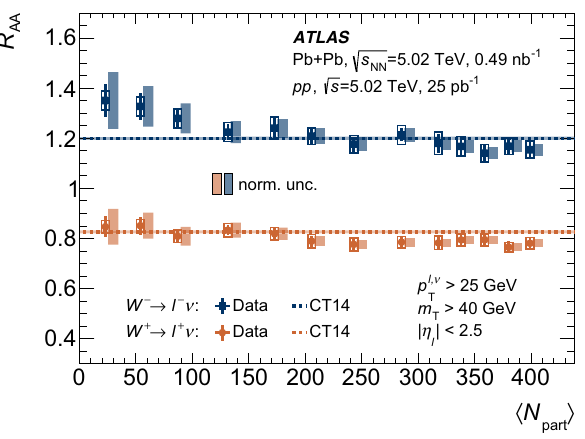
Fig. 14 Nuclear modification factor R AA obtained from the fiducial W + and W − boson production yields as a function of (cid:4) N part (cid:5) . Error bars show statistical uncertainties, whereas systematic uncertainties are shown as the boxes around the data points. The systematic uncertainties due to (cid:4) T AA (cid:5) and luminosity of the pp dataset are not included in those boxes, and are shown as separate shaded boxes plotted to the right of the data points for better